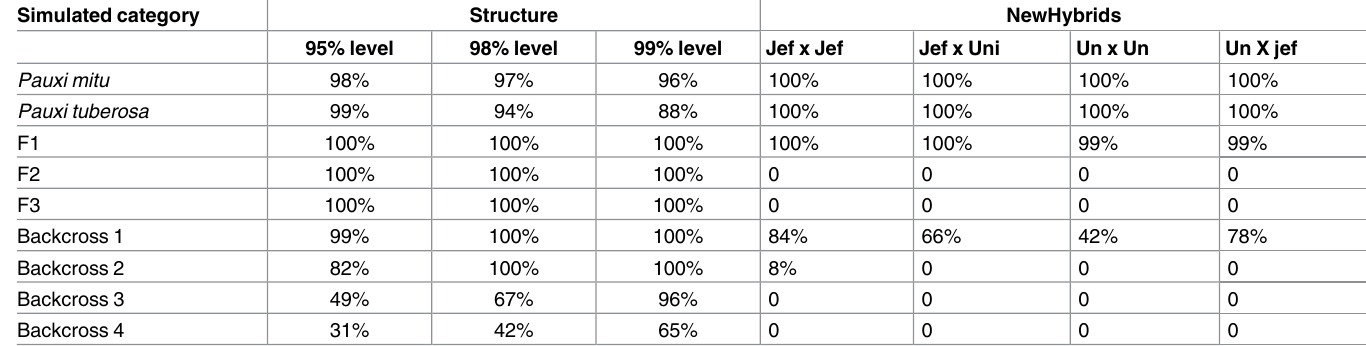
Table 1. Bayesiananalyseswith 100 simulated genotypes of each parental and hybrid class, indicating the percentages of simulated individuals correctly assigned as parental or hybrid, independently of hybrid class attribution for both S TRUCTURE and N EW H YBRIDS . In S TRUCTURE analyses, poten- tial threshold effect was evaluatedusing95, 98 and 99%thresholdlevels,using K = 2. In N EW H YBRIDS , modelingeffect was assessedby testing differentcombi- nationsof Jeffreys (Jef), and Uniform (Un) priors.